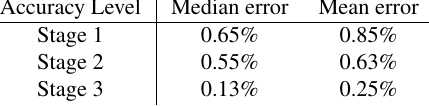
Table 3. Relative error of path length differences (absolute error in Table 1 & 2 and Fig.